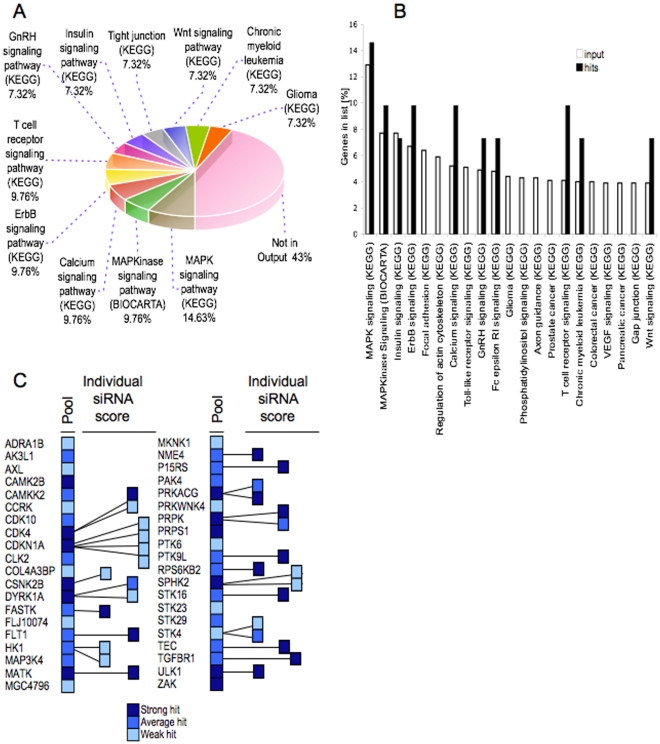
Hit gene-ontology and pathway associations.
A) Pathway representation within hit pool. Hits were analysed for pathway association using the DAVID functional annotation tool (http://david.abcc.ncifcrf.gov/). B) Enrichment for gene ontology. Pathway association was analysed for hits and input using DAVID. Pathway representation within hits is plotted against that for input targets. C) Hit validation. Hits were assessed using individual oligonucleotides represented within the pool. The number of active oligonucleotides and level of response is indicated. Hit classification was as for the screen.